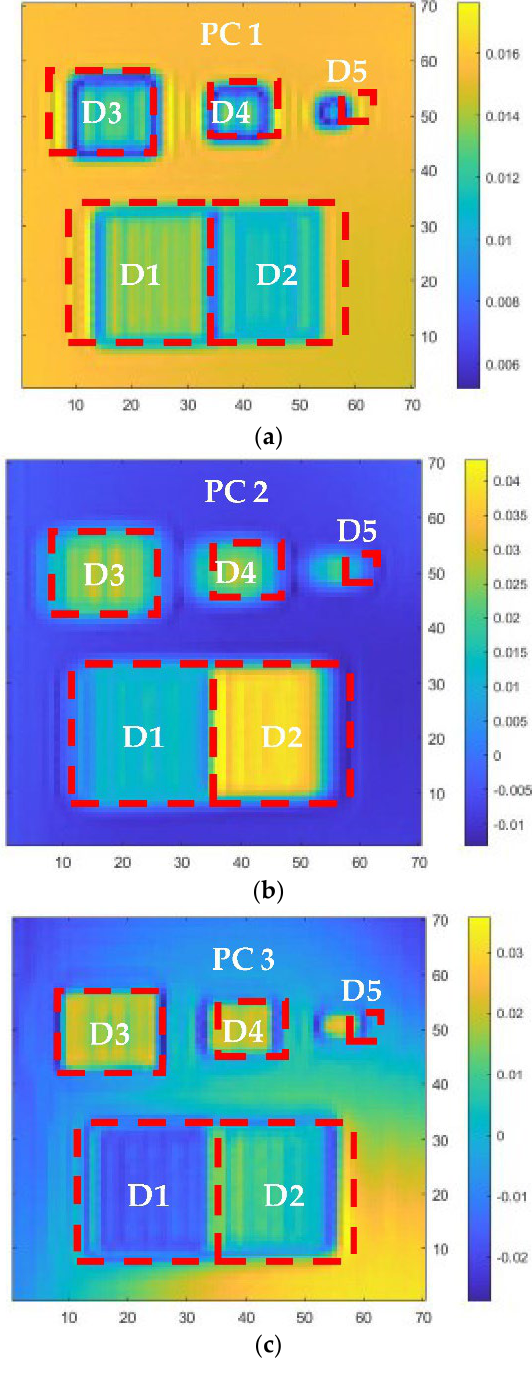
Figure 11. ( a ) PC 1, ( b ) PC 2, ( c ) PC 3 of the Macor sample. The boundaries of the delamination are dispersed throughout all three PCA components. For example, the PC 2 can describe the boundaries of defects D2, D3, and D4. Meanwhile, the boundaries of all defects can be observed clearly in PC 1. In PC 3, only